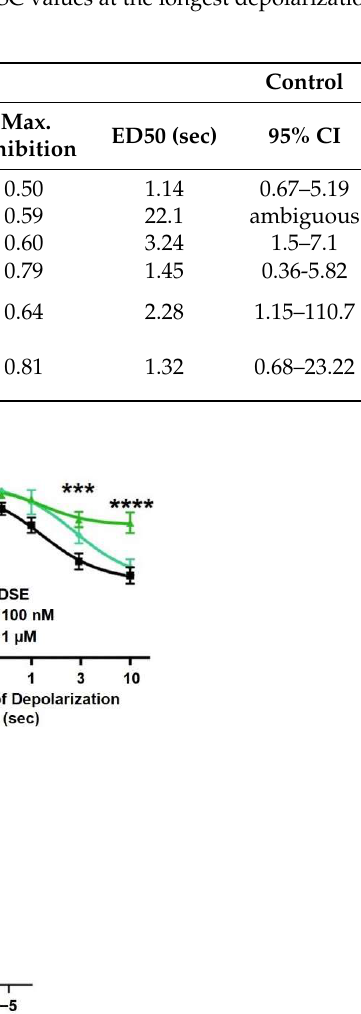
Figure 3. Nerolidol has complex interaction with cannabinoid signaling. ( A ) Nerolidol (1 µM) does not alter EPSC sizes. ( B ) Nerolidol substantially inhibits DSE responses at 1 µM but not at 100